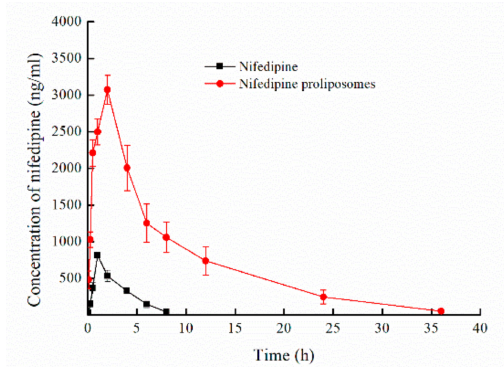
Figure 5. The mean plasma concentration-time profiles of nifedipine proliposomes and nifedipine (n = 5). Nifedipine proliposomes and nifedipine following oral administration in rats at a dose level